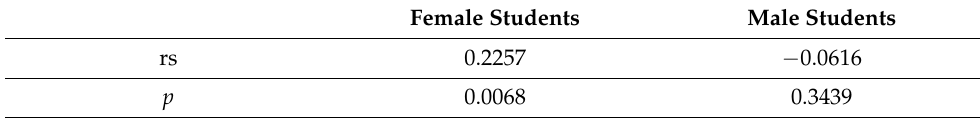
Table 2. Results of the Spearman correlation test—correlation between age and PSS-10.